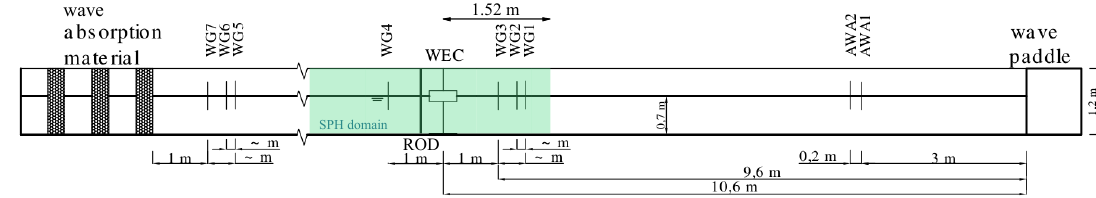
Figure 11. Experimental set-up for tests with a heaving disk type WEC in the large wave flume of Ghent University. The numerical DualSPHysics domain is indicated as a green